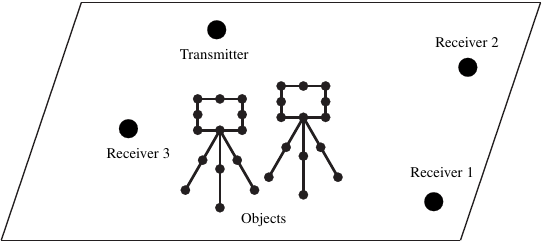
Figure 2. An example of digital map used in the proposed performance-evaluation